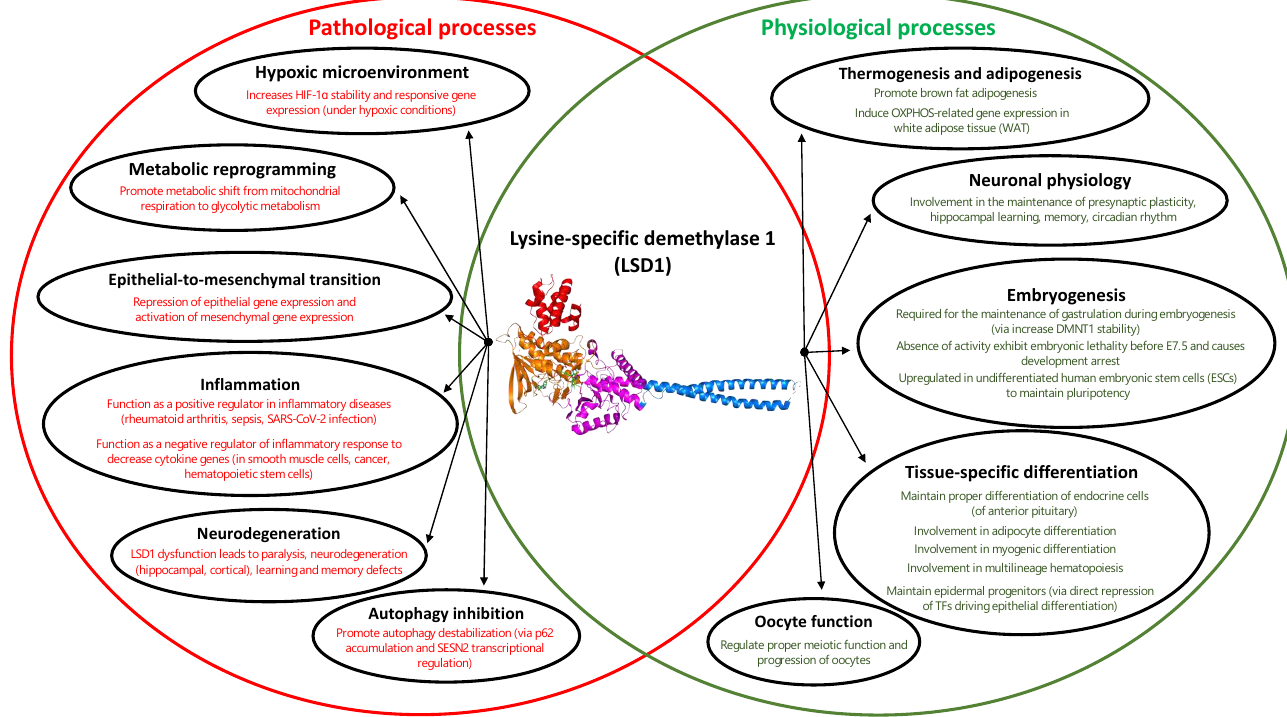
Figure 5. Venn diagram on the comprehensive roles of LSD1 function in both physiological (colored in green) and pathological (colored in red) conditions.